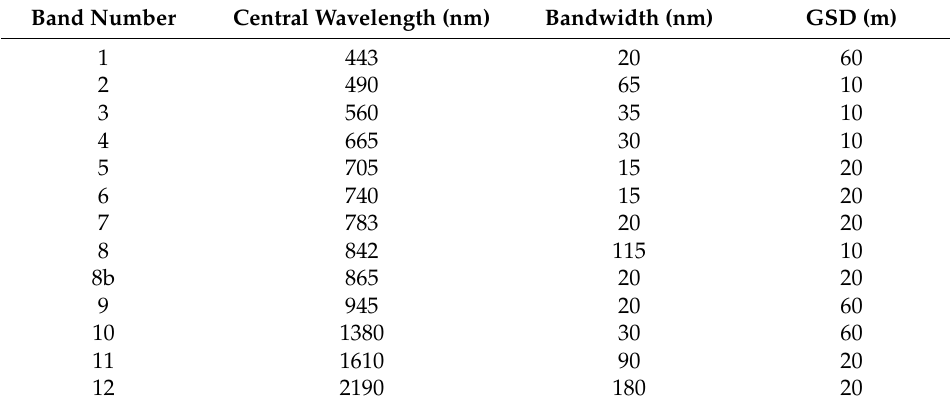
Table 1. Spectral bands for the Sentinel-2